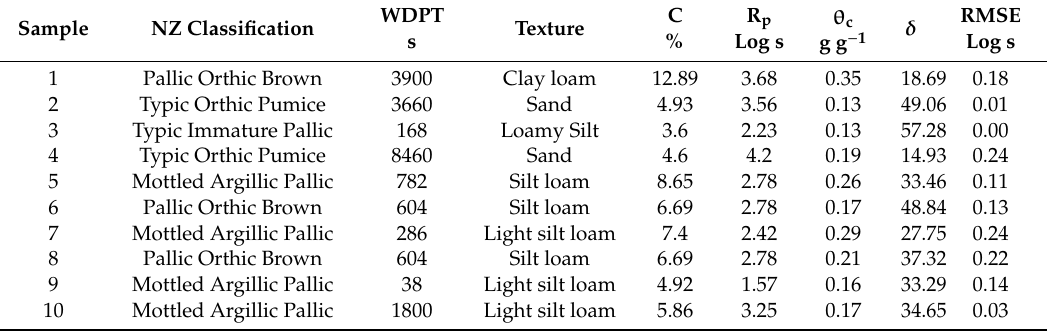
Table 1. Potential soil water repellency (SWR), C content and texture of di ff erent soil samples and the fitted model parameters with their respective RMSE. Water drop penetration time (WDPT) was measured on individual samples using five water drops at five to six